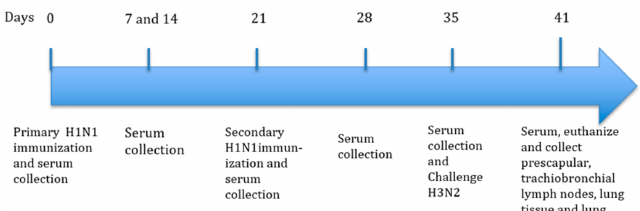
Figure 1. Schematic presentation of experimental design. Piglets were immunized via the intradermal injection with swine influenza virus (SIV) plus PCEP as an adjuvant, on day 0, and a secondary immunization was administered on day 21. Serum was collected for serum antibody titres assays. Clinical and injection site markings and scoring were performed up to day 41 after initial vaccination. Sera from each pig was collected 0, 14, 21, and 28 days post-vaccination and the antigen-specific antibody response (Figure 2A) and antibody neutralization effect against SIV H1N1 and H3N2 (Figure 2B) were assessed to select the groups with optimal antibody responses to the challenge.